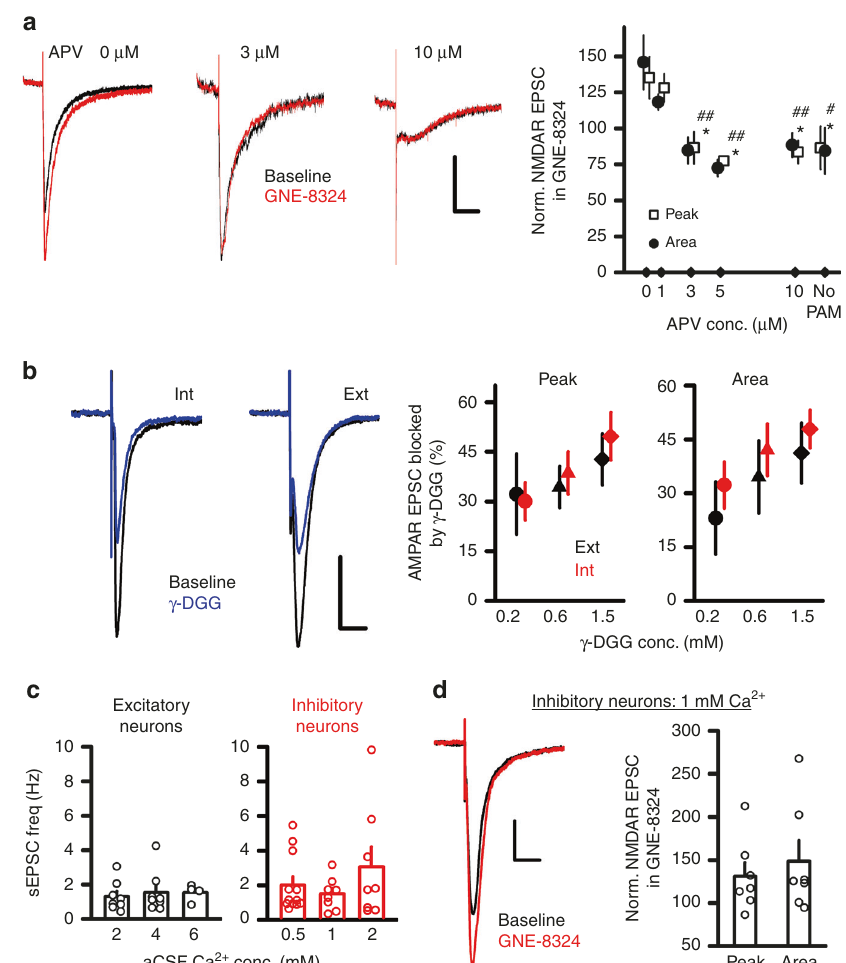
Fig. 3 Synaptically released glutamate does not contribute to GNE-8324 potentiation. a Submaximal D -APV concentrations eliminates GNE-8324 potentiation in inhibitory neurons. Sample traces of NMDAR EPSCs in inhibitory neurons before and after GNE-8324 application in 0, 3, or 10 μ M D -APV. Scale bars, 20 pA/100ms. Dependence of GNE-8324 potentiation on D -APV concentrations. No PAM (GNE-8324) control (Veh with 0 μ M D -APV) shown at the far right. N = 7, 5, 9, 3, 7, 5 for 0, 1, 3, 5, 10 μ M D -APV and no PAM. All compared to 0 μ M D -APV. * P < 0.05; EPSC area. # P < 0.05; ## P < 0.01, one- way ANOVA with Dunnett's correction. EPSC peak amplitude. b Similar blockade of AMPAR EPSCs by γ -DGG in excitatory and inhibitory neurons. Sample traces of AMPAR EPSCs in the absence and presence of γ -DGG in inhibitory (Int) and excitatory (Ext) neurons. Scale bars, 50 pA/20 ms. Similar blockade of AMPAR EPSC peak and area by γ -DGG in excitatory and inhibitory neurons across a range of γ -DGG concentrations (0.2, 0.6, and 1.5 mM). 32.21 ± 12.14% (Peak, Ext, 0.2 mM; mean ± SEM), 30.06 ± 5.62% (Peak, Int, 0.2 mM), P = 0.88; 34.34 ± 6.22% (Peak, Ext, 0.6 mM), 38.57 ± 6.45% (Peak, Int, 0.6 mM), P = 0.66; 42.71 ± 7.78% (Peak, Ext, 1.5 mM), 46.86 ± 6.47% (Peak, Int, 1.5 mM), P = 0.56, 23.08 ± 10.13% (Area, Ext, 0.2 mM), 32.28 ± 6.44% (Area, Int, 0.2 mM), P = 0.47; 34.55 ± 10.15% (Area, Ext, 0.6 mM), 42.09 ± 7.23% (Area, Int, 0.6 mM), P = 0.60; 38.16 ± 9.03% (Area, Ext, 1.5 mM), 49.67 ± 7.24% (Area, Int, 1.5 mM), P = 0.39, unpaired t test. c Spontaneous release of synaptic glutamate does not contribute signi fi cantly to GNE-8324 potentiation in inhibitory neurons. Elevating [Ca 2 + ]Ext from 2 to 4 or 6 mM did not signi fi cantly increase sEPSC frequency in excitatory neurons. 1.32 ± 0.30 Hz (2 mM), 1.44 ± 0.39 Hz (4 mM), 1.54 ± 0.24 Hz (6 mM); N = 8, 8, 4. Reducing [Ca 2 + ]Ext from 2 to 1 or 0.5 mM reduced sEPSC frequency in inhibitory neurons (2.01 ± 0.48 Hz (0.5 mM), 1.50 ± 0.33 Hz (1 mM), 3.08 ± 1.16 Hz (2 mM); N = 12, 8, 8). d Signi fi cant GNE-8324 potentiation in inhibitory neurons at 1 mM [Ca 2 + ]Ext. Scale bars, 50 pA/50 ms. Error bars represent SEM possible in inhibitory neurons due to higher ambient glutamate To examine whether GluN2C/2D-containing NMDARs may levels within the synaptic microenvironment. However, another contribute to GNE-8324 potentiation, we used NAB-14 ( N -aryl formal possibility consistent with these results is that the gluta- benzamide), a selective antagonist of GluN2C/2D-containing mate levels are unchanged, but (at least a fraction of) synaptic NMDARs (diheteromeric GluN1/2C and GluN1/Glu2D NMDARs in inhibitory neurons are more sensitive to glutamate NMDARs, as well as triheteromeric GluN1/2A/2C NMDARs) 57 . A signi fi cant reduction in NMDAR EPSCs was seen after 20 μ M and can therefore by potentiated. In particular, expression of NAB-14 application in inhibitory neurons, but not in excitatory GluN2C/GluN2D-containing NMDARs is higher in inhibitory neurons (Fig. 6a; Supplementary Figure 9; 71.70 ± 3.54% (peak, neurons 54 – 57 and NMDARs composed of GluN2C or GluN2D subunits have higher glutamate sensitivity 15 . This could theore- Int/NAB-14), 95.20 ± 4.25% (peak, Int/Veh); 71.92 ± 4.31% (area, tically allow greater GNE-8324 potentiation of triheteromeric Int/NAB-14), 101.0 ± 3.25% (area, Int/Veh); 93.95 ± 7.91% (peak, GluN1/2A/2C and/or GluN1/2A/2D NMDARs in inhibitory Ext/NAB-14), 103.7 ± 10.92% (area, Ext/NAB-14); P (peak) < neurons. 0.05, P (area) < 0.05, Int/Veh vs. Int/NAB-14; P (peak) < 0.05, P NATURE COMMUNICATIONS| (2018) 9:4000 |DOI: